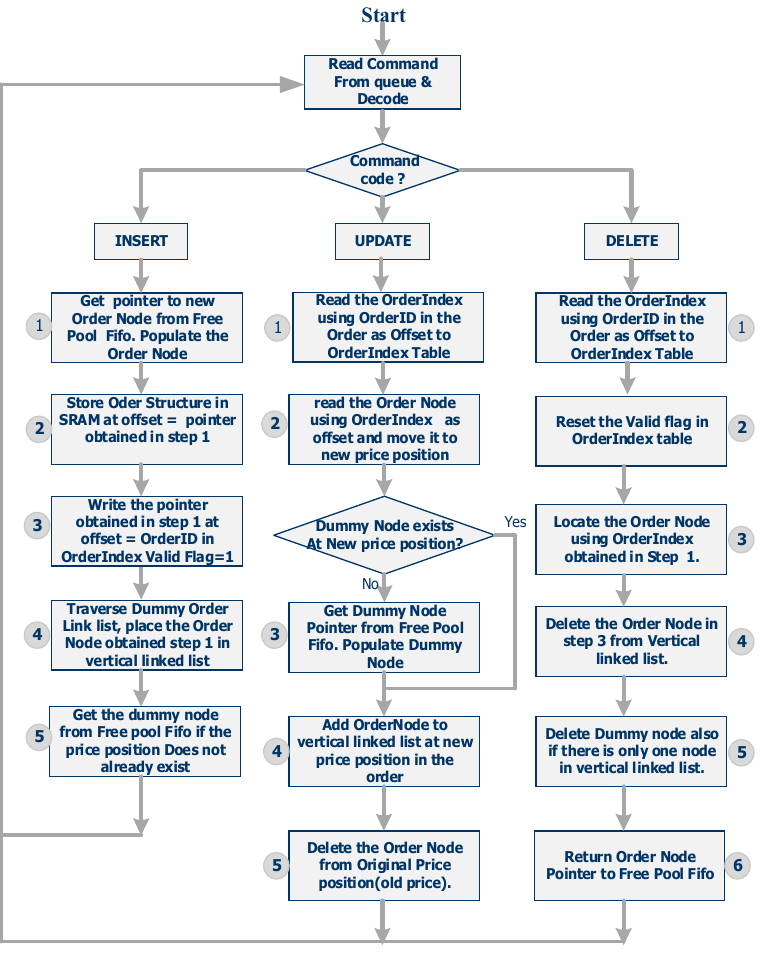
Figure 8. Algorithms for the execution of the INSERT, UPDATE, and DELETE commands.